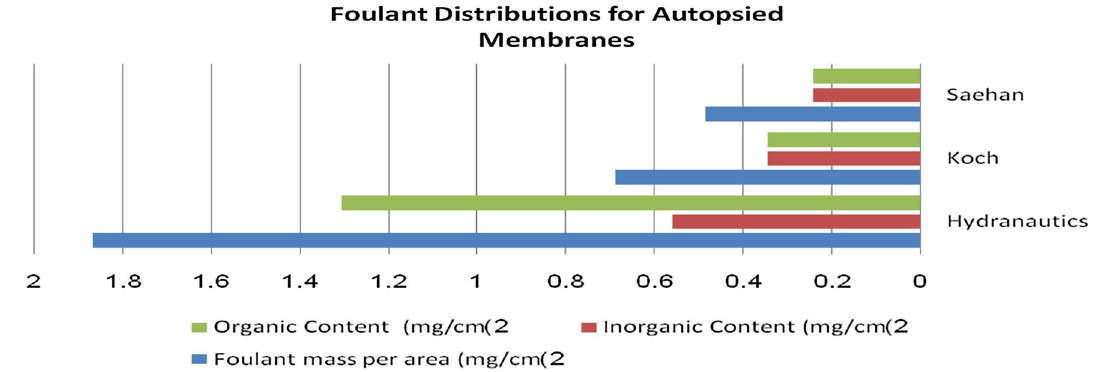
Fig. 6 Foulant distribution of autopsied